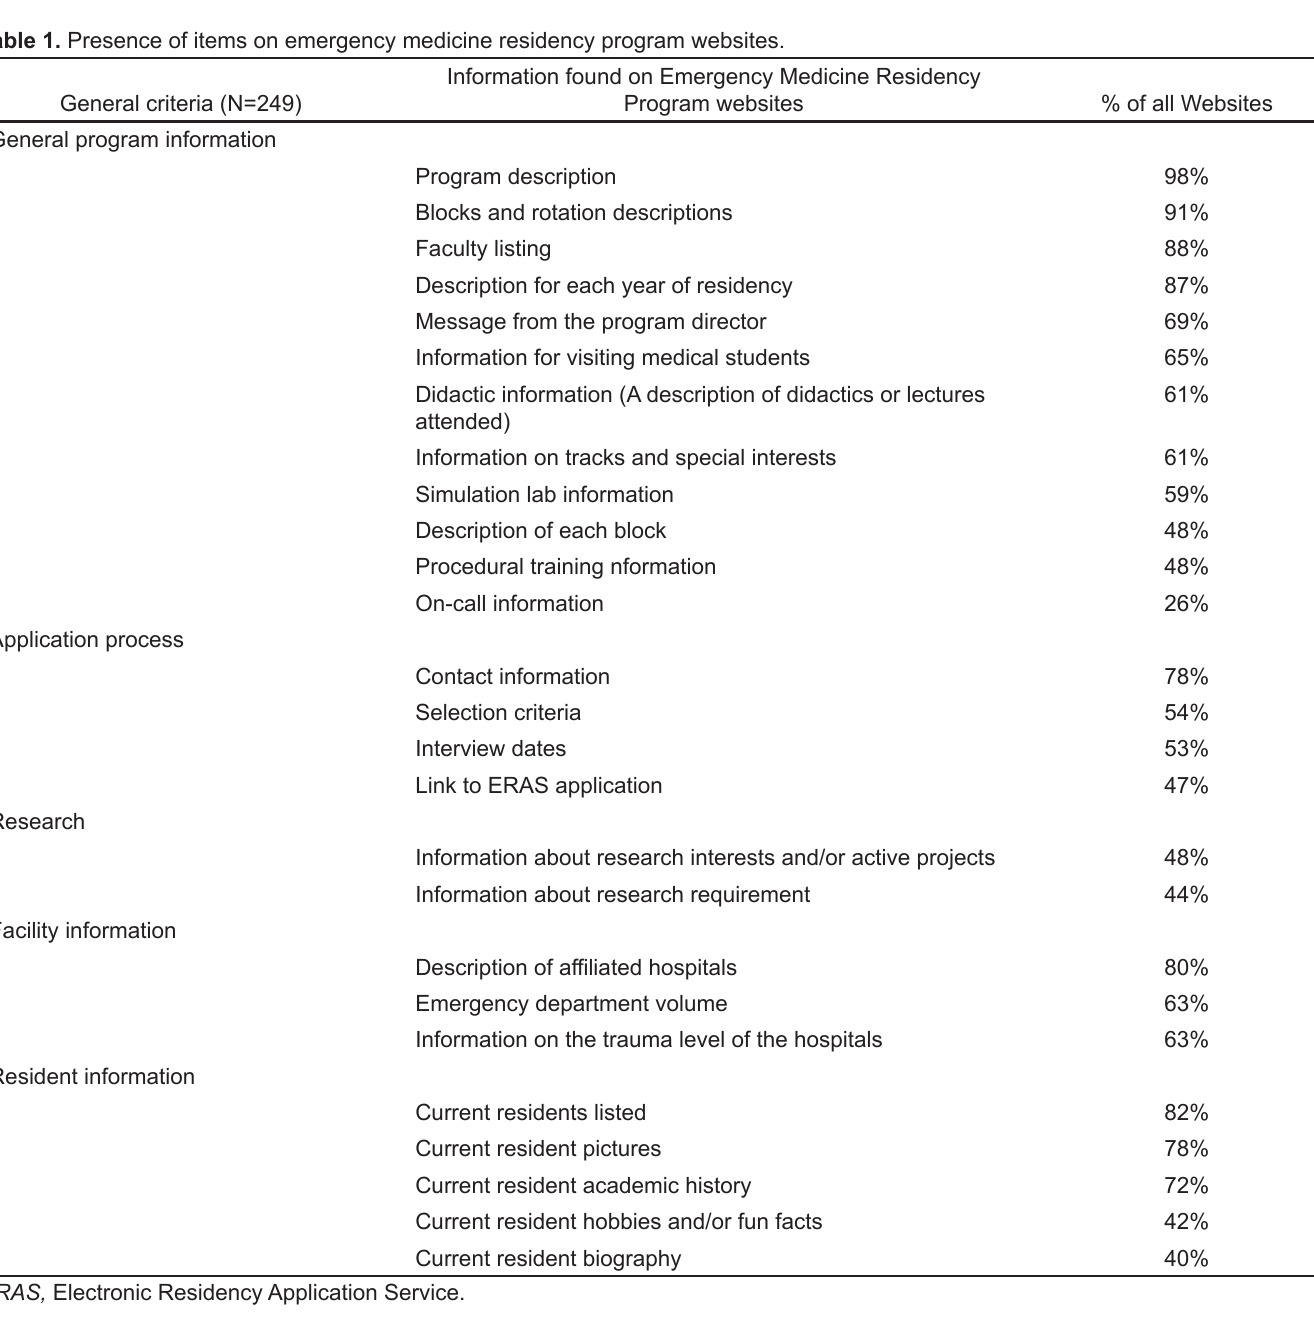
Table 1. Presence of items on emergency medicine residency program websites.